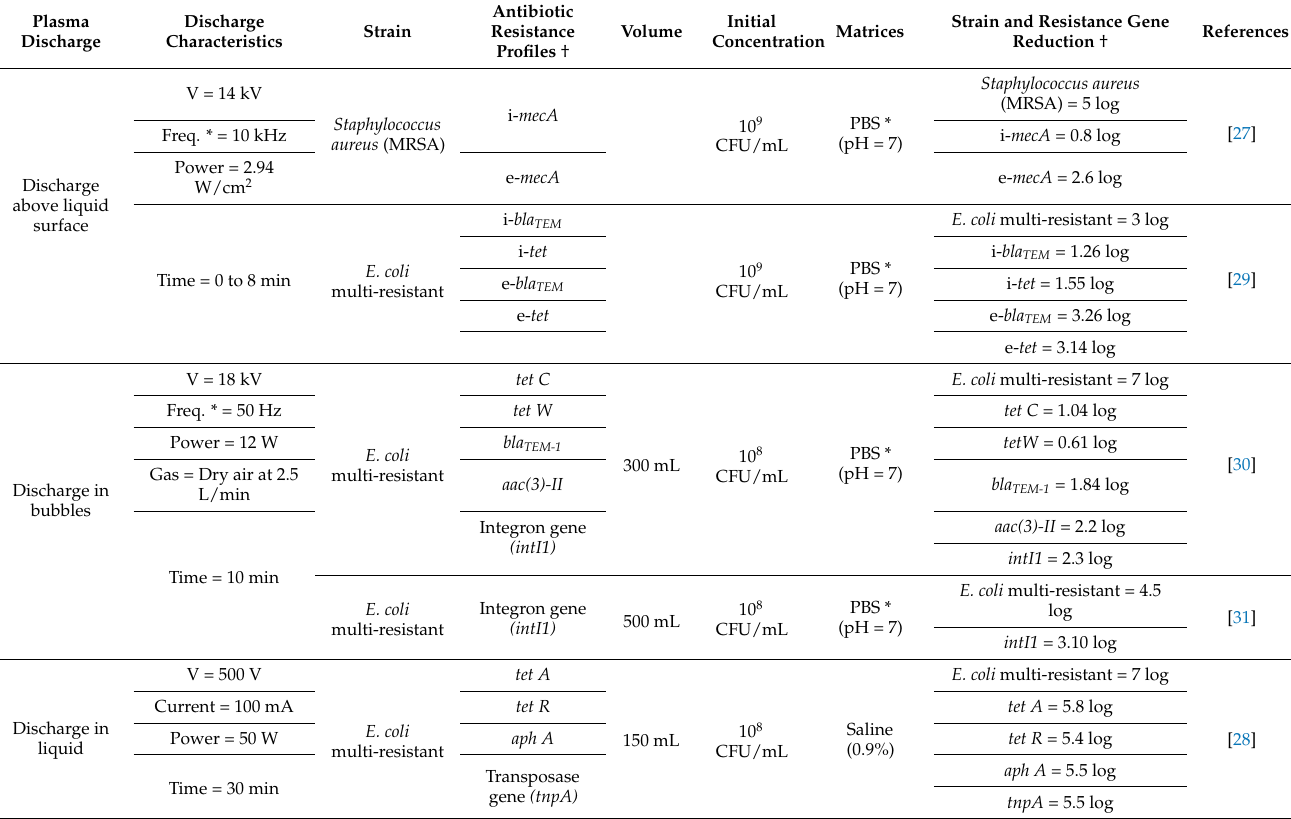
Table 2. Literature overview of different types of plasma discharges used for wastewater